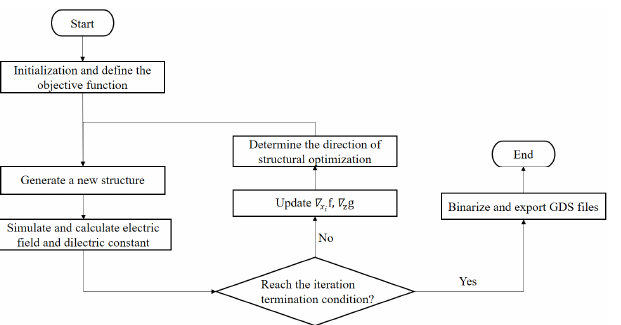
Figure 1. The flow chart of the RDM. ∇ xi f and ∇ z g are the gradients of the objective functions ( f and g ) to the electric field ( x i ) and dielectric constant ( z ), respectively.